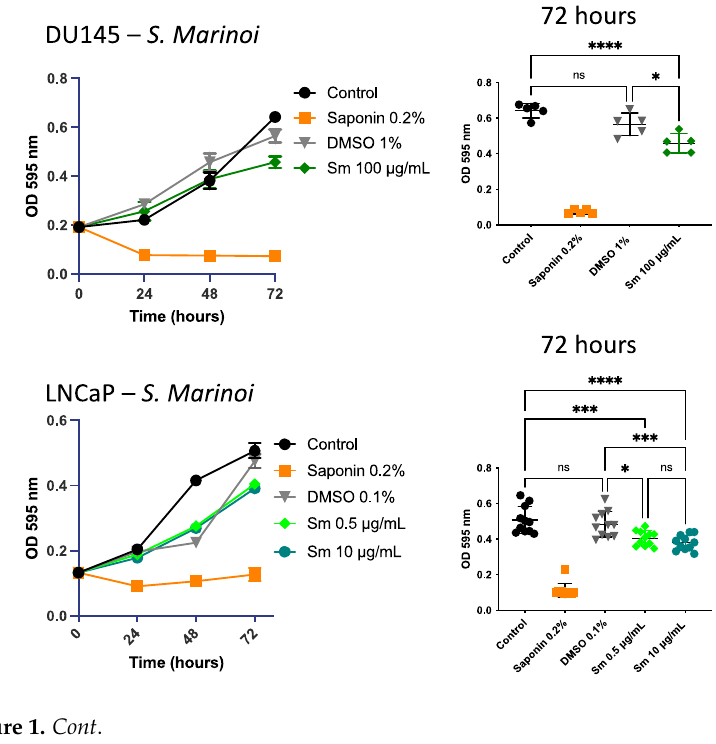
Figure 1. E ff ects of S. marinoi extract on prostate cancer (PCa) cell line proliferation. The proliferation rate was measured by ( A ) crystal violet assay (OD 595 nm) at 72 h and ( B ) MTT (OD 570) at 48 h. DU145 cells were treated with S. marinoi (Sm) at 1–10–100 µg/mL, LNCaP cells were treated with Sm